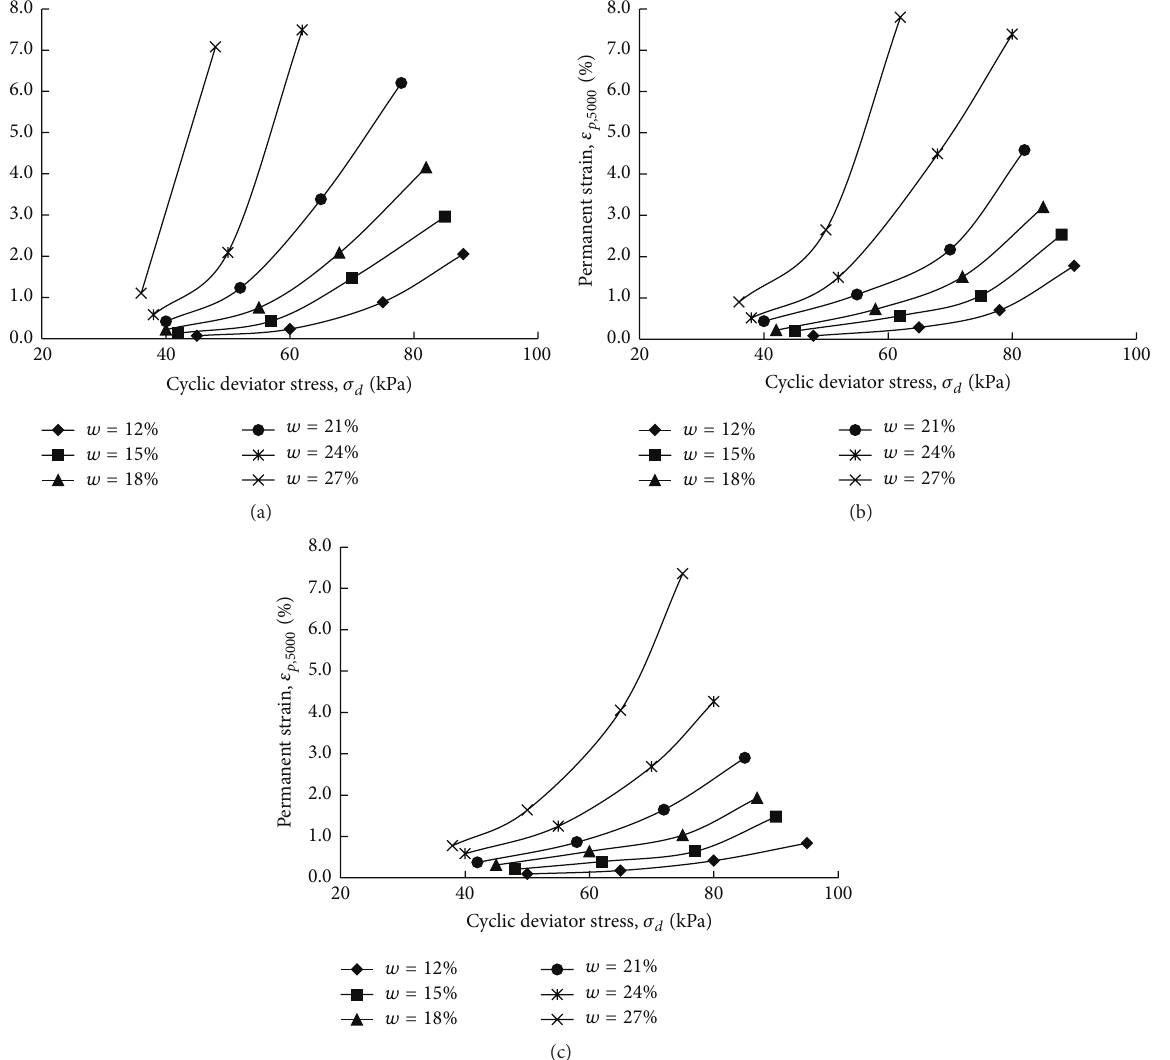
Figure 6: Relationships between permanent strain after 5000 cycles and cyclic deviator stress for different moisture contents and degrees of compaction: (a) 𝑘 = 90 %; (b) 𝑘 = 93 %; (c) 𝑘 = 96